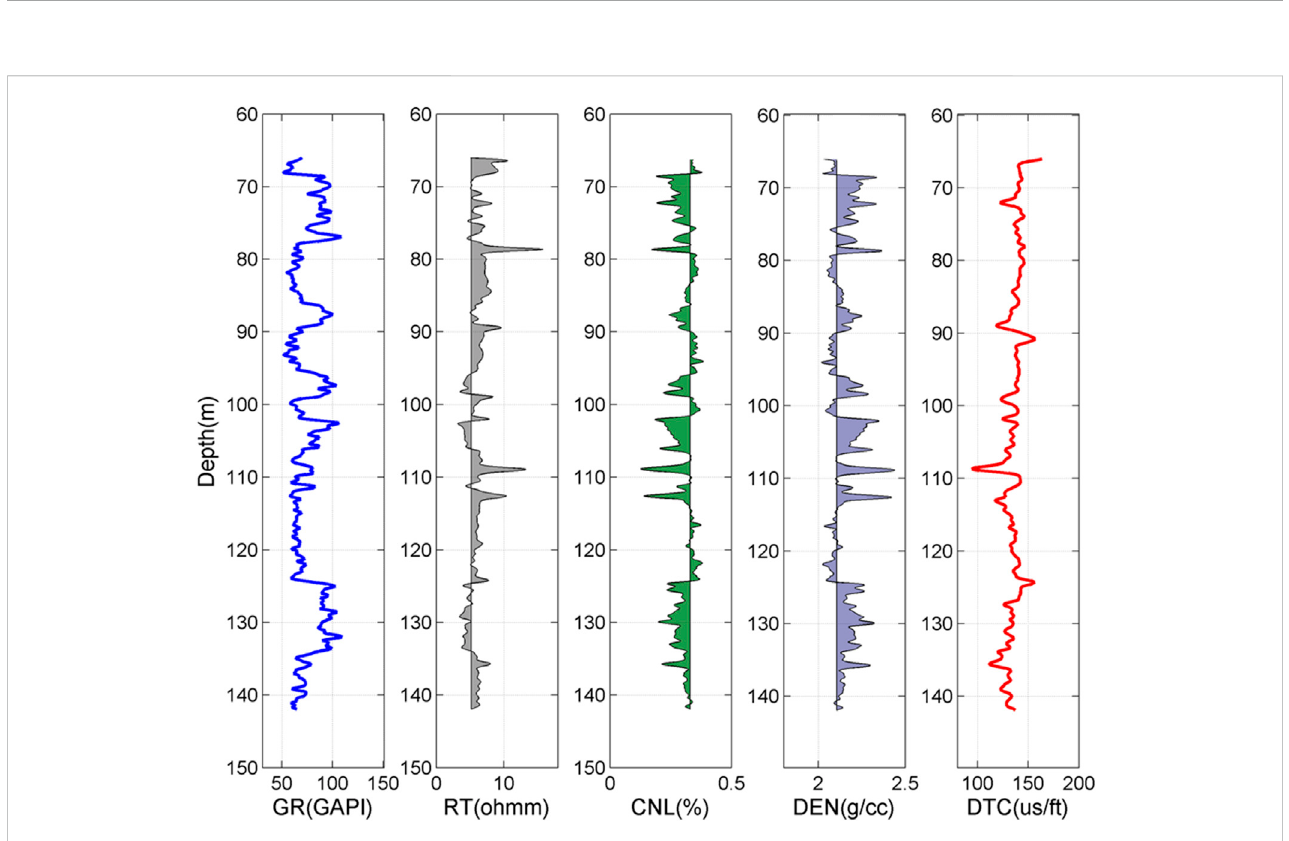
FIGURE 11 Well logs of well #2. Note that this well does not include the S-wave velocity